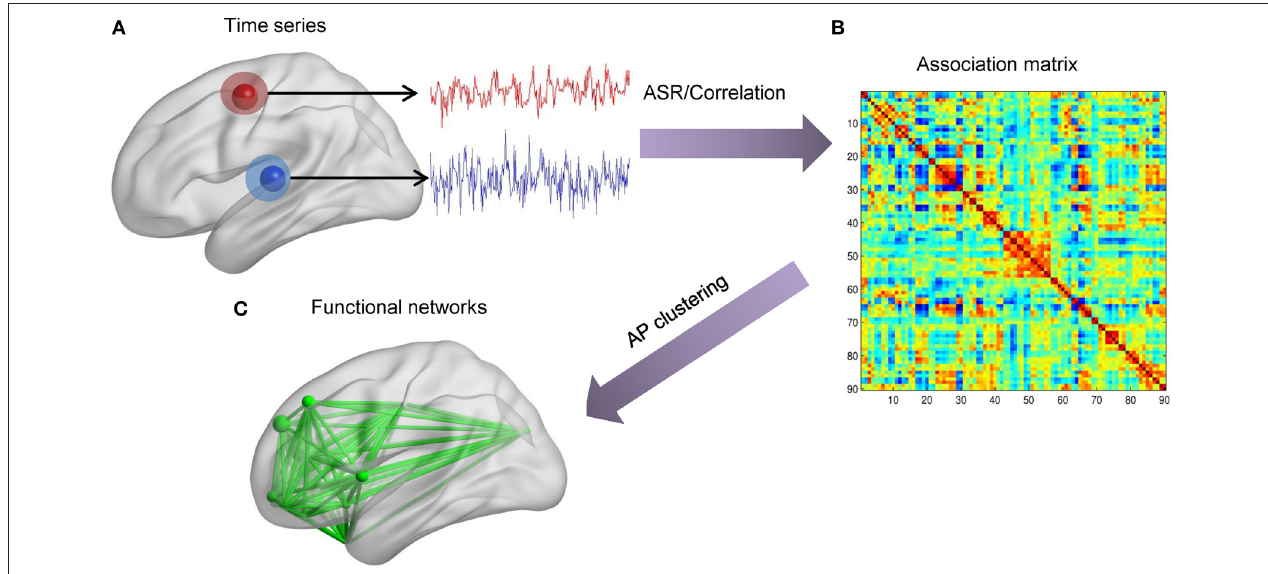
FIGURE 2 | The scheme of identifying brain functional networks. (A) Extract time series of each node defined by the AAL template. (B) Use ASR or the Pearson correlation to compute the association matrix. (C) Identify sub-networks by using the AP clustering algorithm based on the association matrix.